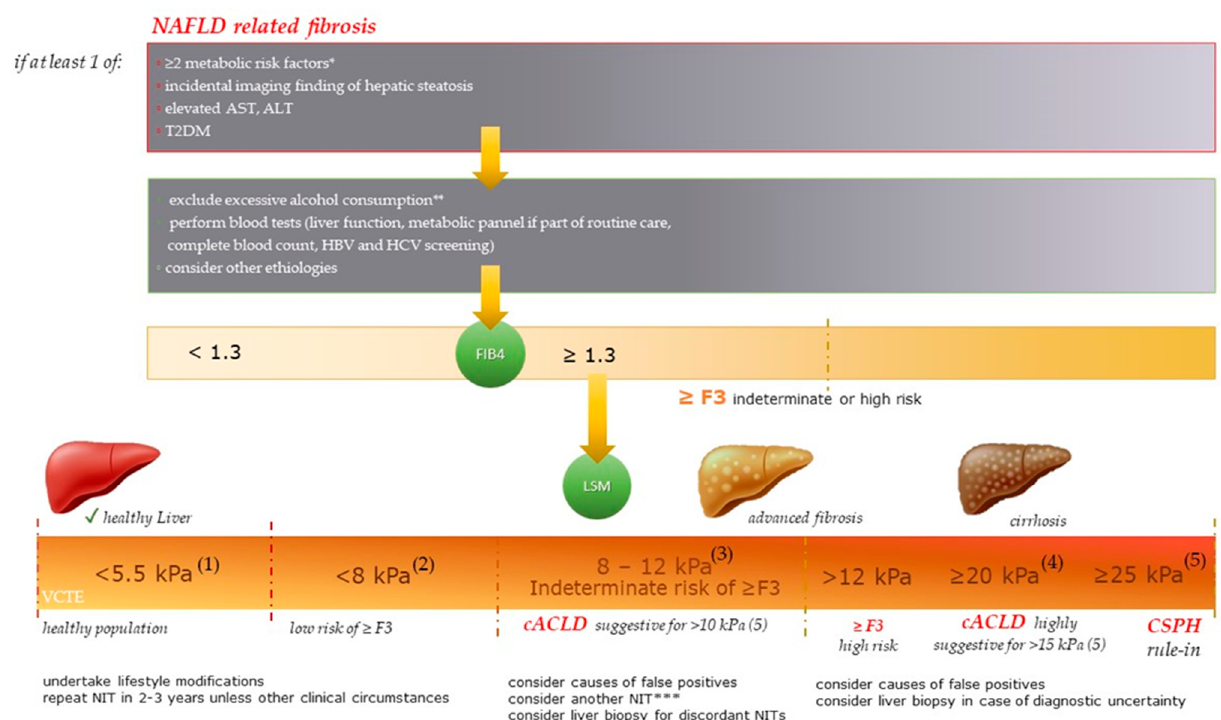
Figure 4. Screening algorithm for NAFLD ‐ related Fibrosis. * the metabolic conditions include cen ‐ tral obesity—waist circumference with ethnicity ‐ specific cut ‐ offs, serum triglycerides ≥ 150 mg/dL or specific treatment for hypertriglyceridemia, reduced serum high ‐ density lipoprotein cholesterol <40 mg/dL in males (<50 mg/dL in females) or those undergoing a specific treatment, systolic blood pressure ≥ 130 mmHg, or diastolic blood pressure ≥ 85 mmHg or specific treatment, raised fasting plasma glucose between 100 mg/dL and 125 mg/dL (prediabetes) [128,129]; T2DM—type